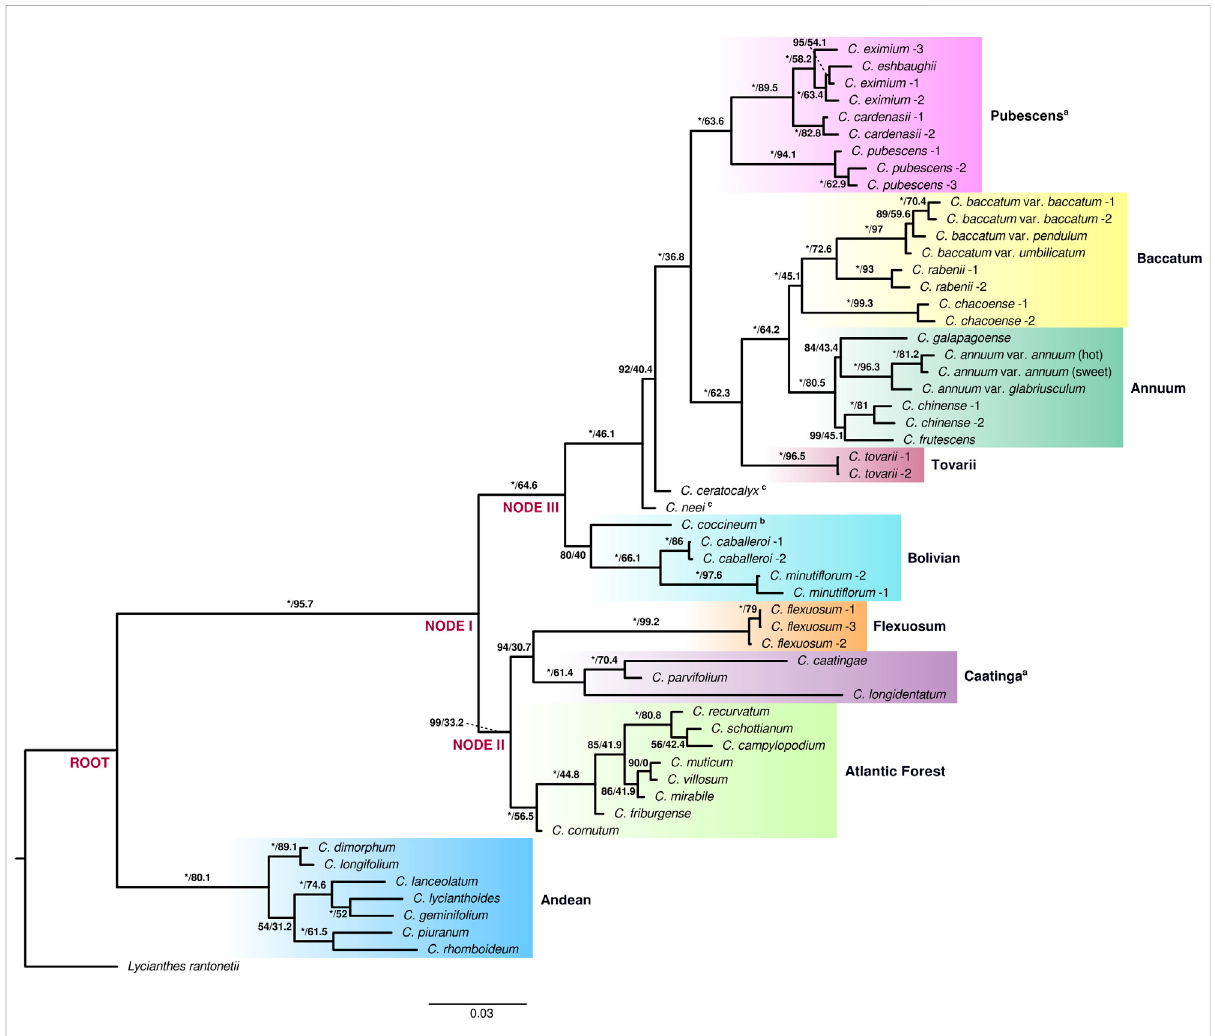
FIGURE 1 Best-scoringmaximumlikelihoodphylogenetictreefor Capsicum .Cladesidenti fi edareshadedwithdifferentcolorsandlabeled; a cladesnewly circumscribed, b provisional placement, c speciesnotassignedto anyclade.Samplesidenti fi edaccordingtoSupplementary Table S1.Support values by branches correspond to ultrafast bootstrap (UFBoot) and site concordant factors. UFBoot = 100% represented by